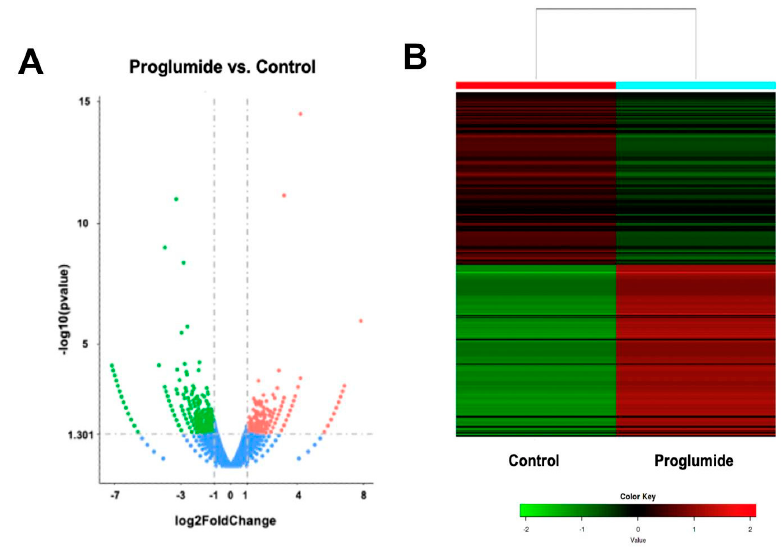
Figure 7. Differentially expressed genes in proglumide-treated human HepG2 HCC cells. ( A ) Volcano plot shows 369 upregulated (pink) and 616 downregulated genes (green) with proglumide as determined by RNA sequencing. Genes not significantly changed are blue. ( B ) Heat map of up- and downregulated genes.